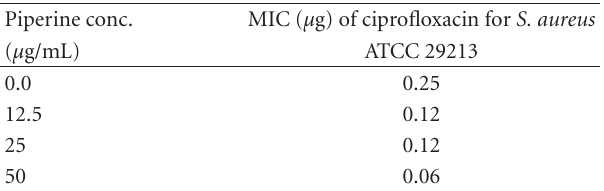
Table 10: MIC of ciprofloxacin for S. aureus ATCC 29213 at di ff erent concentrations of piperine